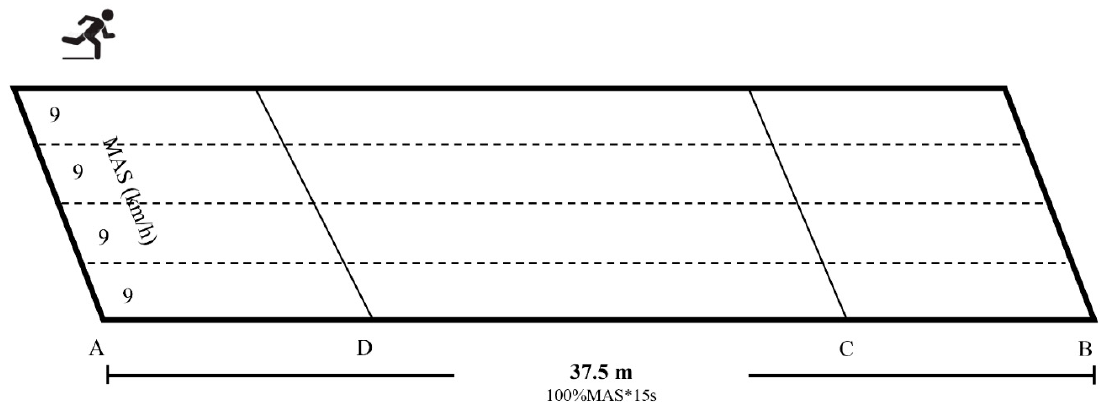
Figure 1. Schematic chart of running path. * means multiply.